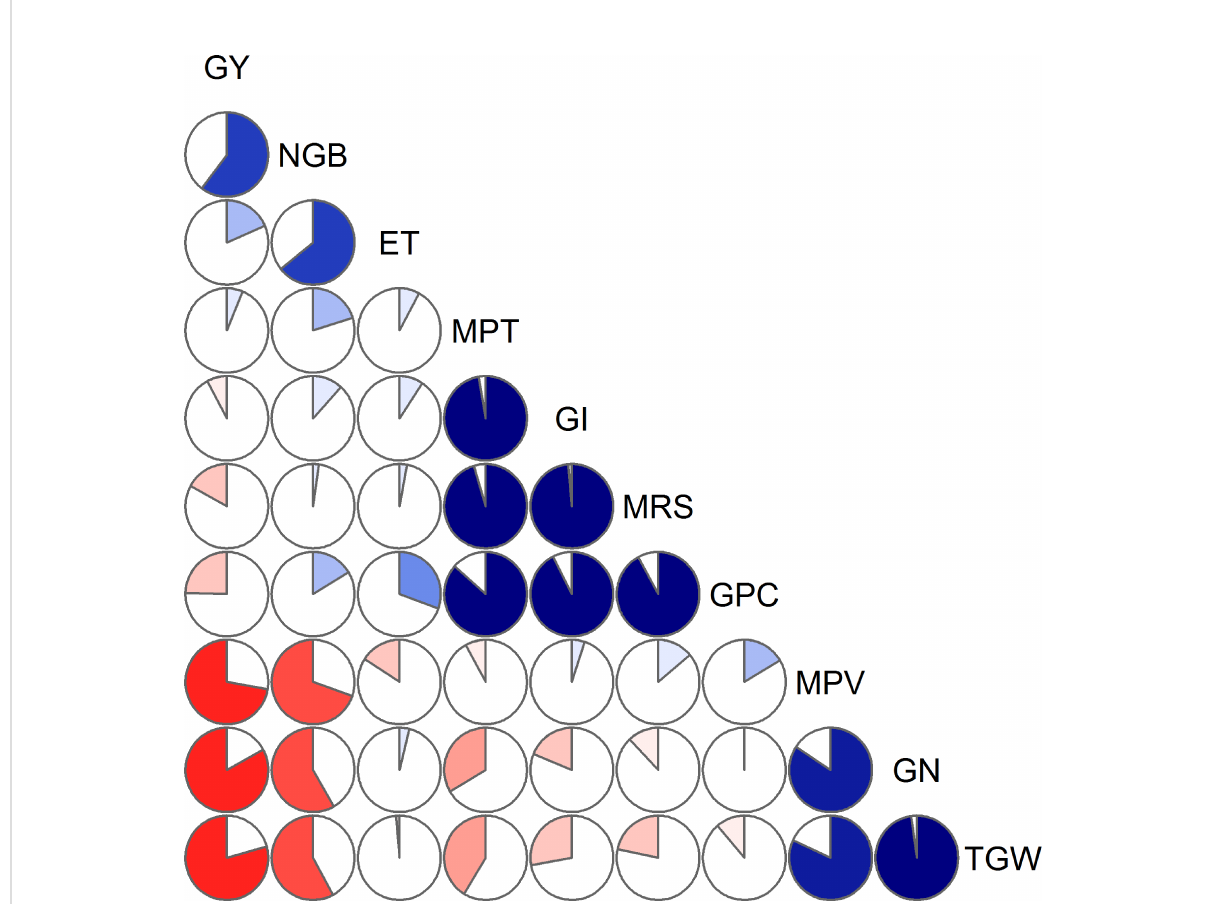
FIGURE 3 Correlation diagnosis of grain yield, evapotranspiration, and quality parameters. Blue color represents a positive correlation between the two variables that meet at that cell. Conversely, red color represents a negative correlation. The darker and more saturated the color, the greater is the magnitude of the correlation. GY, grain yield (g/barrel); NGB, number of grains per barrel; ET, evapotranspiration (L/barrel); MPT, midline peak time (minute); GI, gluten index (%); MRS, right of midline peak slope (% torque/minute); GPC, grain protein concentration (%); MPV, midline peak value (% torque); GN, grain nitrogen content (mg/grain); TGW, thousand-grain weight